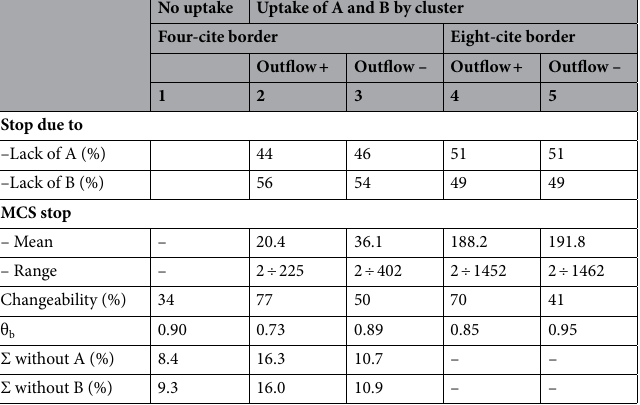
Table 4. Results of the kinetic Monte Carlo simulations; previous algorithm is completed by the ability of cluster to uptake reagents from its border; particles A are consumed at each fifth step, particles B are also consumed at each fifth, three steps after A; substrate coverage is kept constant; designations as in Table